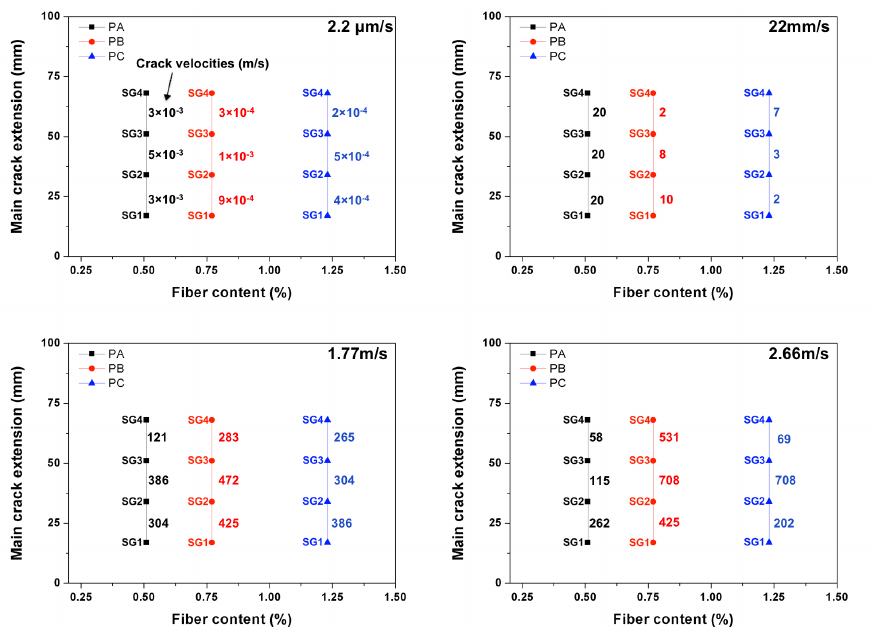
Figure 13. Typical crack velocities marked (in m/s) along the main crack path for concrete PA, PB and PC loaded at four loading rates: 2.2 µ m/s, 22 m/s, 1.77 m/s and 2.66 m/s, respectively.